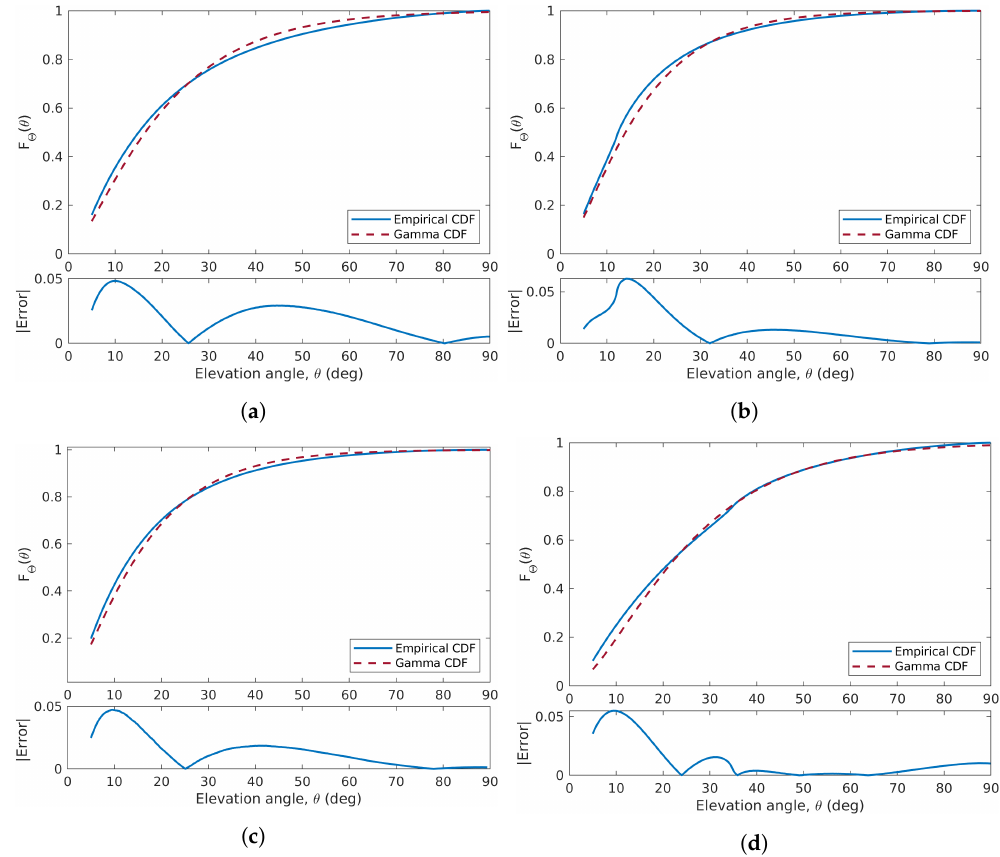
Figure 10. Comparison and error of the empirical and Gamma elevation angle CDF’s for different ES latitudes, φ ES , orbit inclinations of the satellites, i SAT , and, orbit altitudes, h k . ( a ) CDF’s for φ ES = 30 ◦ and i SAT = 30 ◦ at h k = 1000 km; ( b ) CDF’s for φ ES = 45 ◦ and i SAT = 65 ◦ at h k = 1000 km;